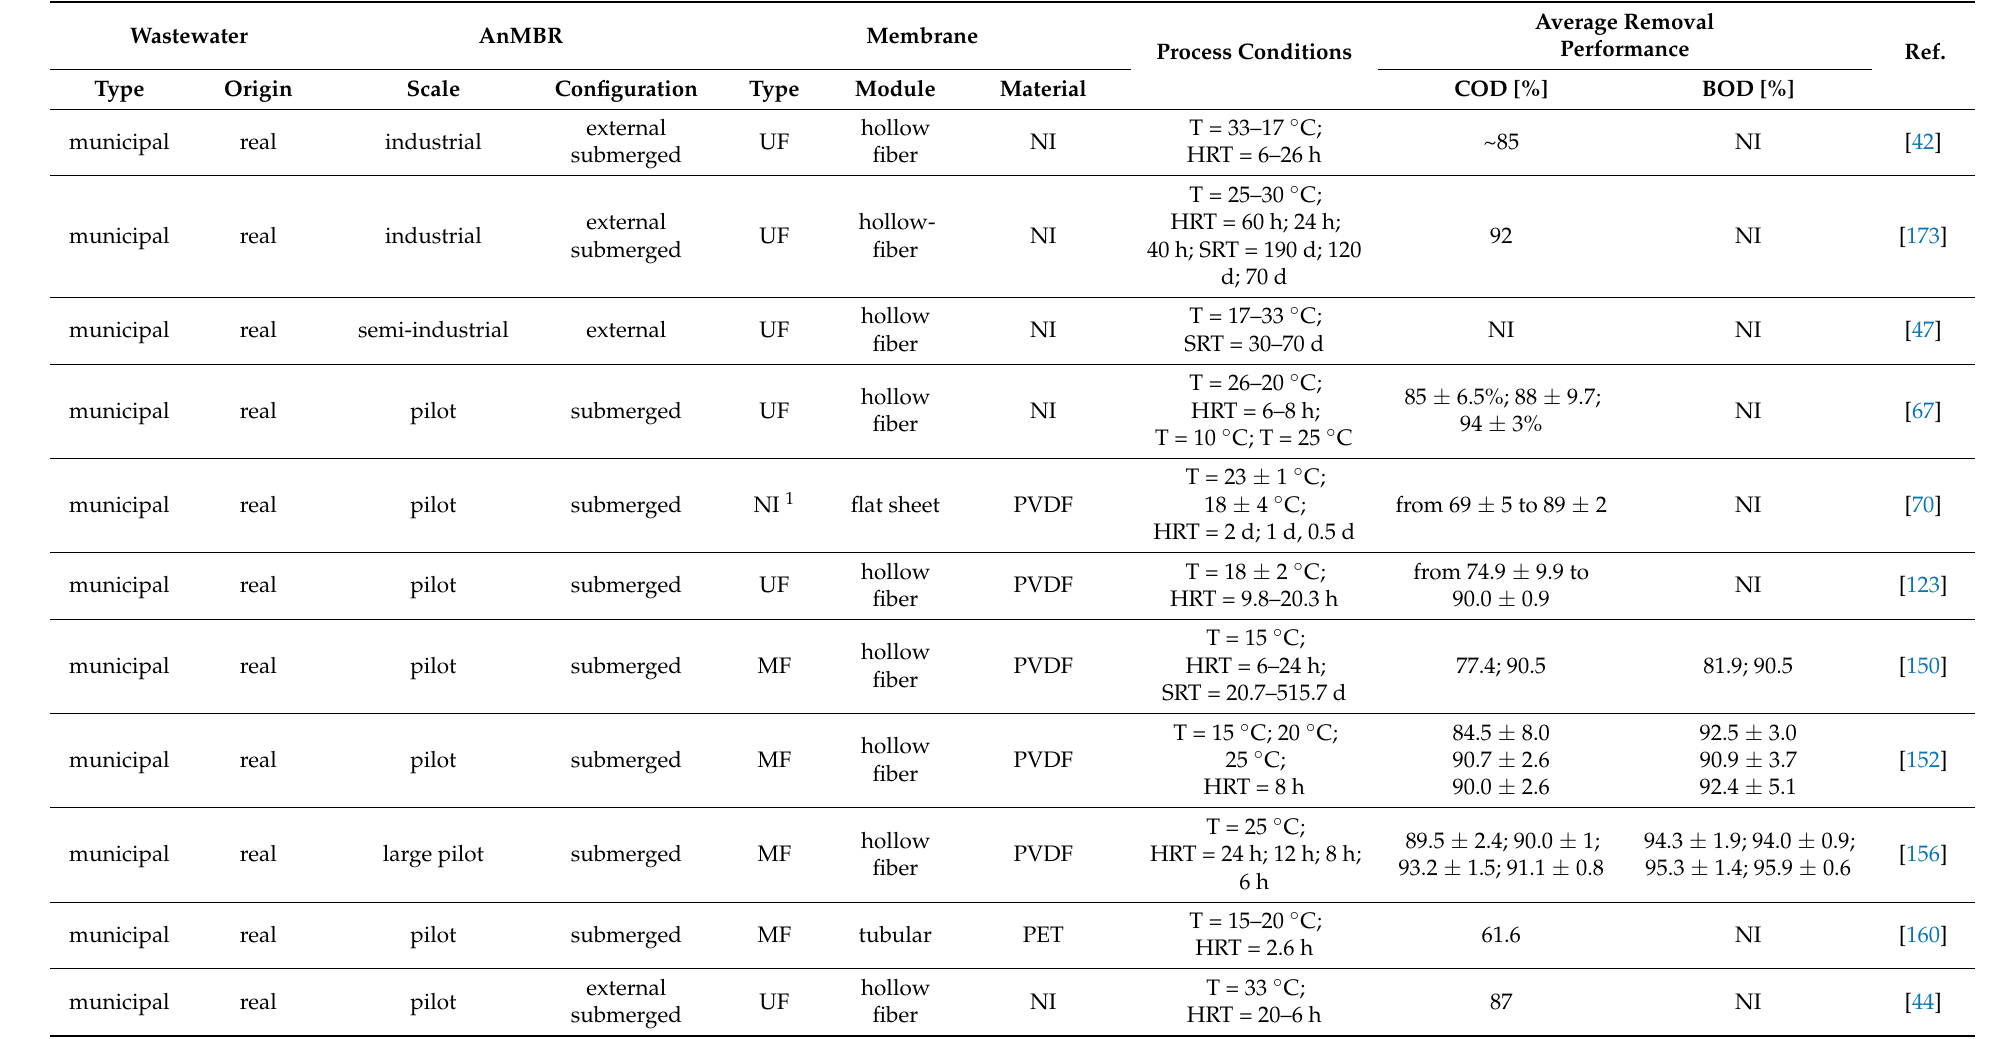
Table 4. Summary of the studies on the treatment of municipal wastewaters in